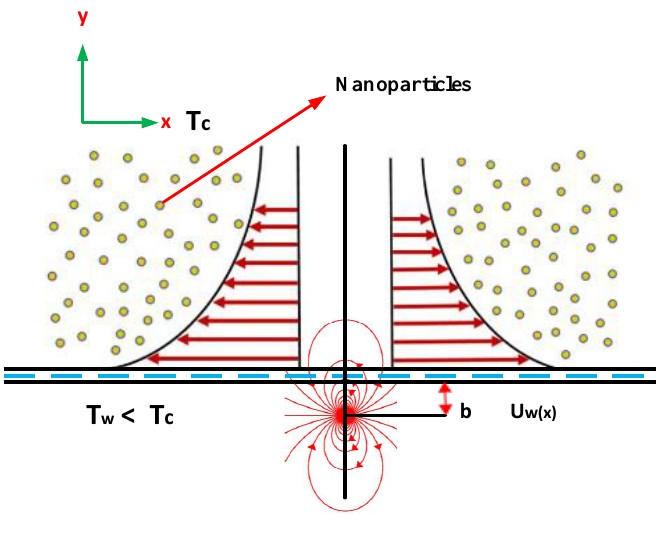
Figure 1. Configuration of the flow